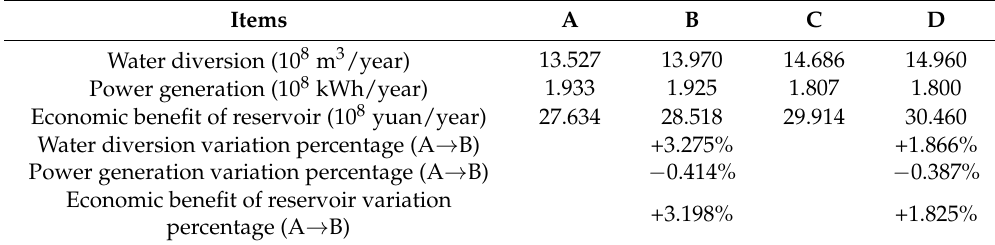
Figure 6. Pareto front of MOEA/D-AWA. Table 3. Comprehensive benefit analysis of solutions on segments AB and CD.